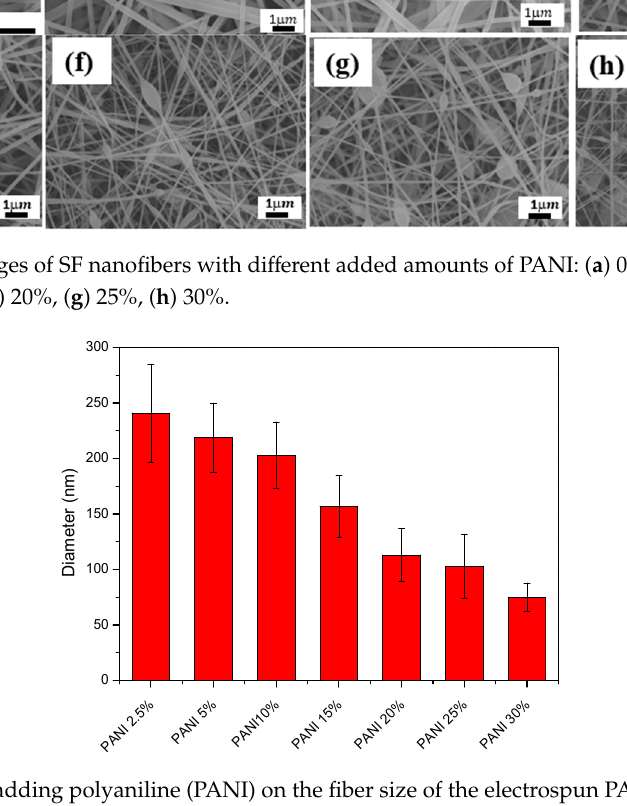
Figure 4. E ff ect of adding polyaniline (PANI) on the fiber size of the electrospun PANI / SF nanofibers. Table 2. The porosity of the electrospun PANI / SF composite nanofibers’ mats with various amounts of PANI. PANI 2.5%